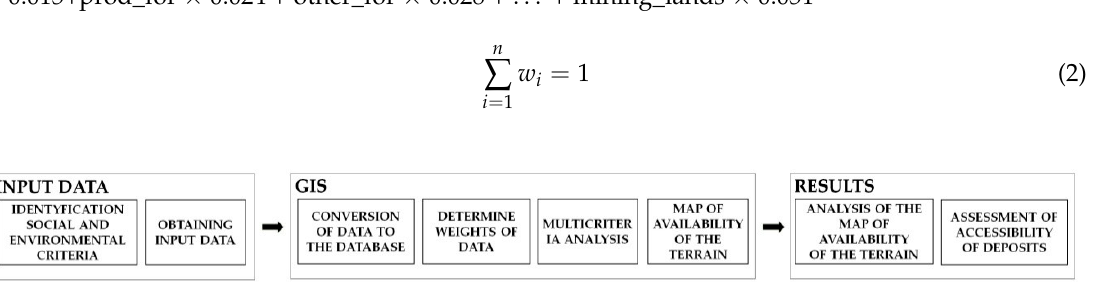
Figure 2. Methodology for assessing the accessibility of deposits of crushed and dimension stones in the environmental and social aspect.